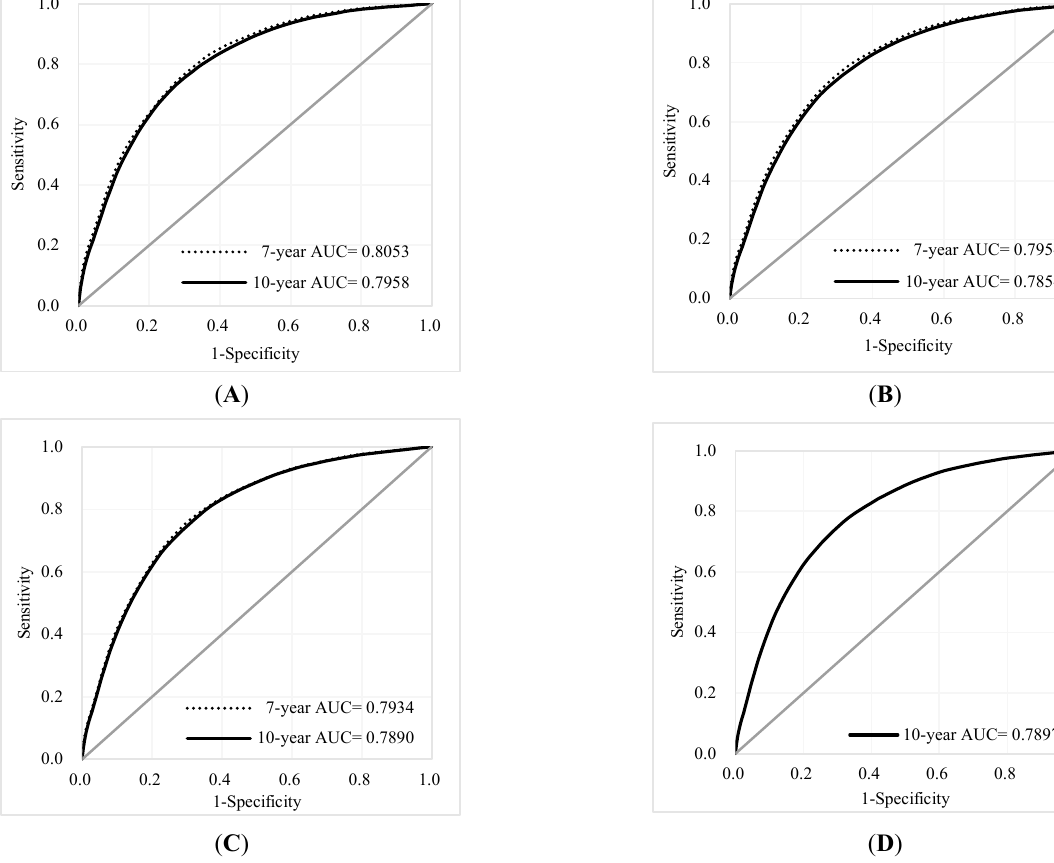
Figure 3. ROC curves and AUCs at different time points for the 7-year and 10-year follow-ups: ( A ) 2nd year; ( B ) 4th year ( C ) 6th year, ( D ) 8th year for 10-year only.